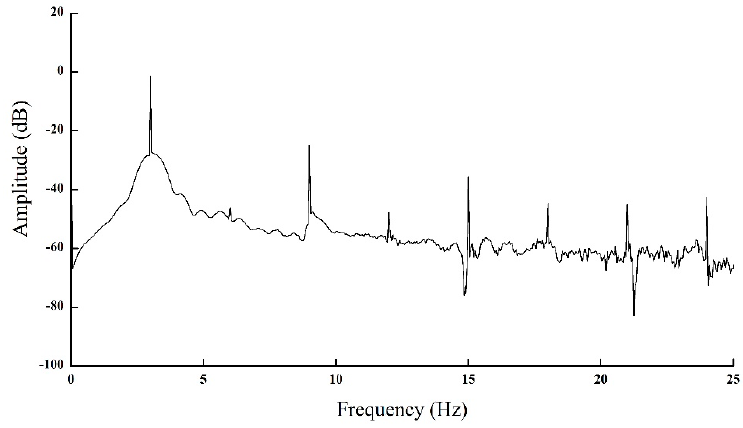
Figure 3. Acceleration response of sin( 2 3 t π× ) m/s 2 in frequency domain.